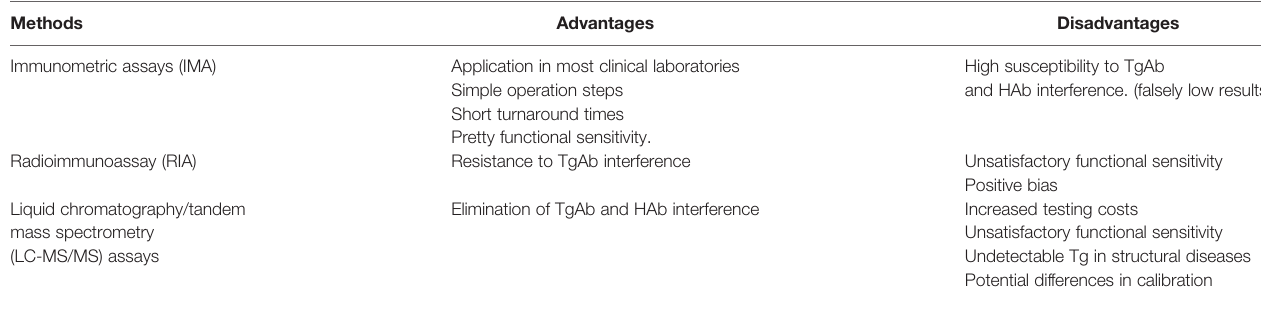
TABLE 3 | Thyroglobulin measuring methods in patients with differentiated thyroid